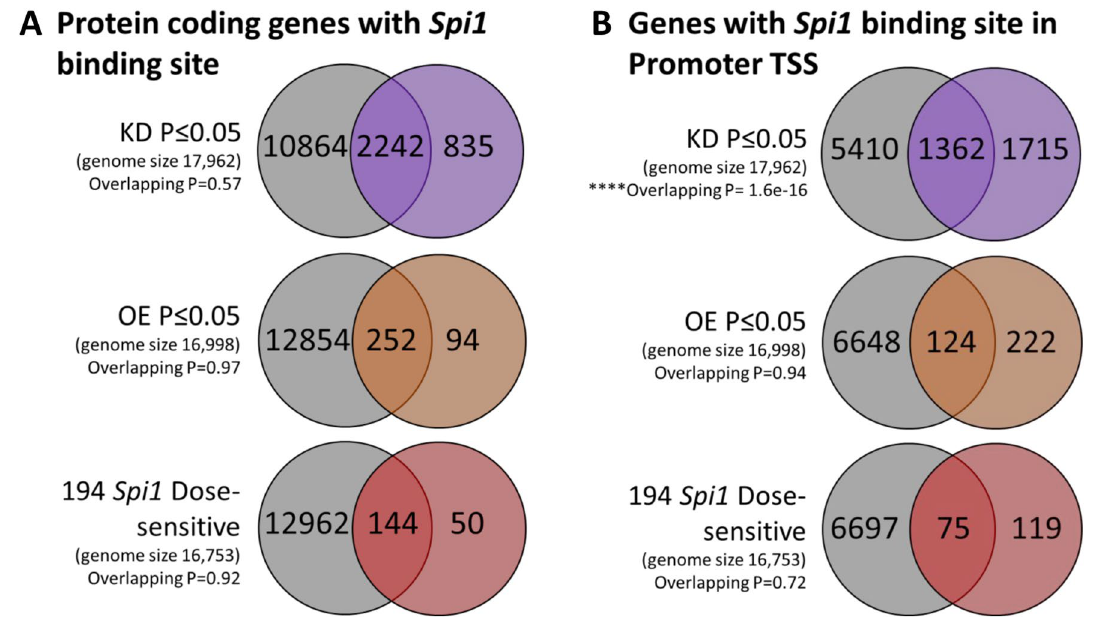
Figure 5. Comparison of Spi1 KD, Spi1 OE and 194 Spi1 Dose-sensitive genes to Spi1 /PU.1 Chip-Seq dataset. Spi1 binding sites were determined from PU.1 Chip-Seq published data available online 30 as described in methods. Fisher’s exact tests were used to determine if there was a significant overlap between the datasets ( A ) includes the results from all protein coding genes with a Spi1 binding region (defined by Chip-seq in grey) that are also expressed in KD (purple), OE (orange) RNA-seq datasets or the Spi1 dose-sensitive genes (red). ( B ) The proportion of genes expressed in the RNA-seq datasets that contained a Spi1 binding site within the promoter region. The KD dataset contained a significant number of genes with a Spi1 binding sequence in the promoter (Fisher’s exact test, overlapping p value = 1.6 × 10 −16 ). No significant enrichment was noted in either the Spi1 OE or dose sensitive genes. Figures were made in PowerPoint based on results from ‘GeneOverlap’ 48 package in RStudio 39,40